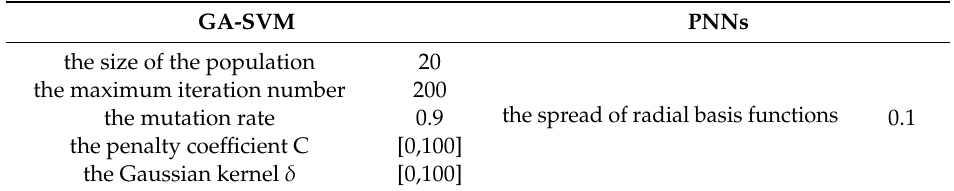
Table 1. Parameters for the Genic Algorithm optimization Support Vector Machine (GA-SVM) and Probabilistic Neural Networks (PNNs).